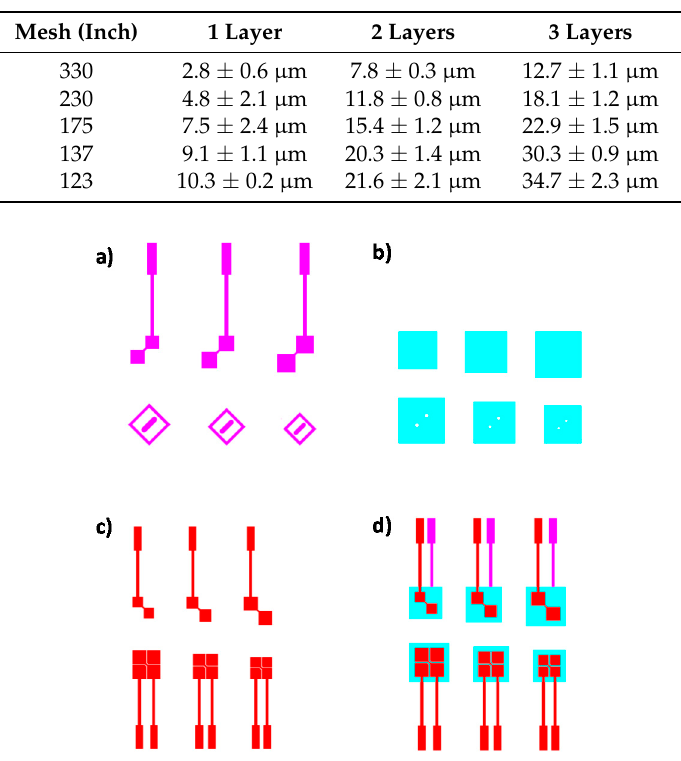
Table 3. Final layer thickness depending on mesh value and number of layers.